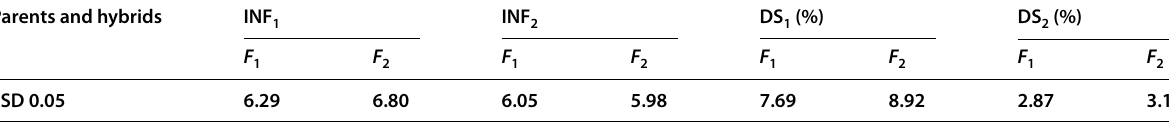
Table 4 Heterosis (%) in F over mid (H) and better parents (Hb) for studied traits 1